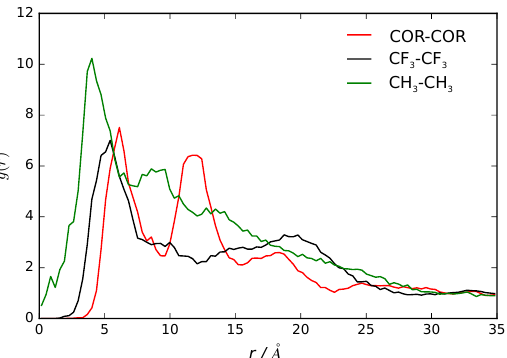
Figure 5. Radial distribution functions of the center of the central phenylene ring (COR), CF 3 and CH 3 terminal groups of B16/10 molecules within the DPPC bilayer.